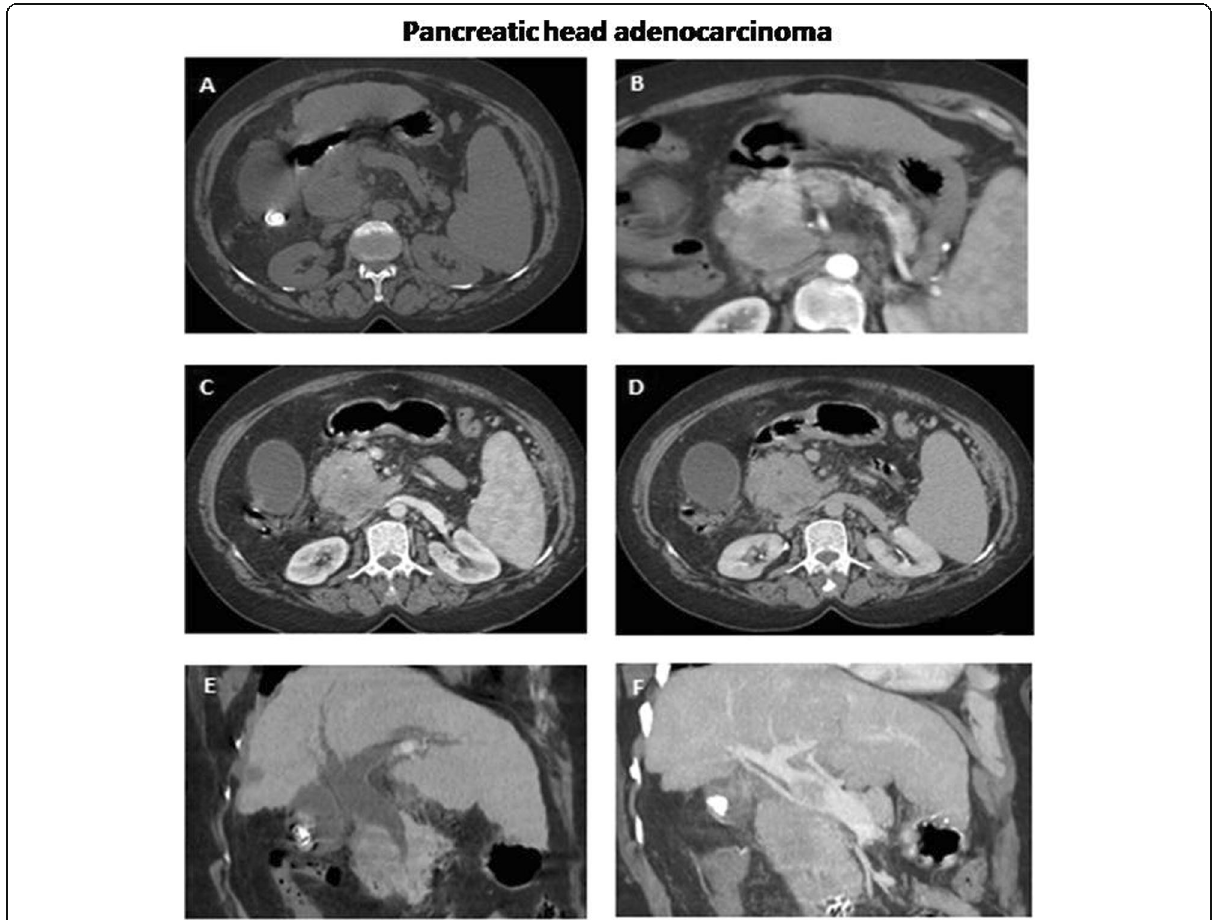
Fig. 1 Pancreatic head adenocarcinoma. Malignant obstructive jaundice due to pancreatic head adenocarcinoma (pathologically proved) with moderate intra- and extra-hepatic biliary dilatation and PV thrombosis. Male patient, 55 years old, presented with jaundice, abdominal pain, anorexia, and cachexia. a Axial non-contrast, b axial oblique reformatted post-contrast (arterial phase), c axial (portal phase), and d axial (delayed phase) images showing fairly defined pancreatic head mass that is poorly enhancing at the arterial and venous phases, being isodense at delayed phases. e Coronal oblique MinIPreformatted MDCT cholangiography image showing moderately dilated CBD till its distal end where the mass encroaches upon it. f Coronal oblique MIP reformatted MDCT cholangiography images showing partially thrombosed